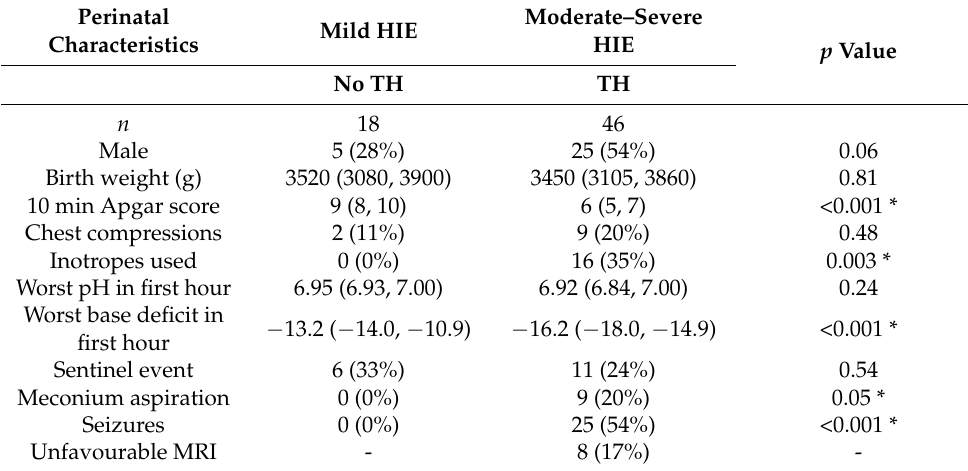
Table 1. Baseline characteristics of the studied